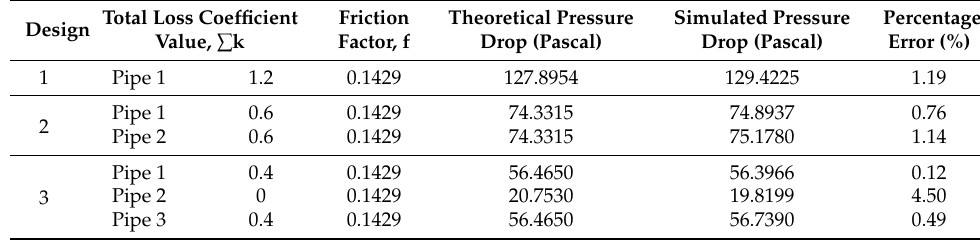
Figure 14. Effect of the number of bends on a pipe’s pressure drop. Table 10. Simulated and theoretical pressure-drop